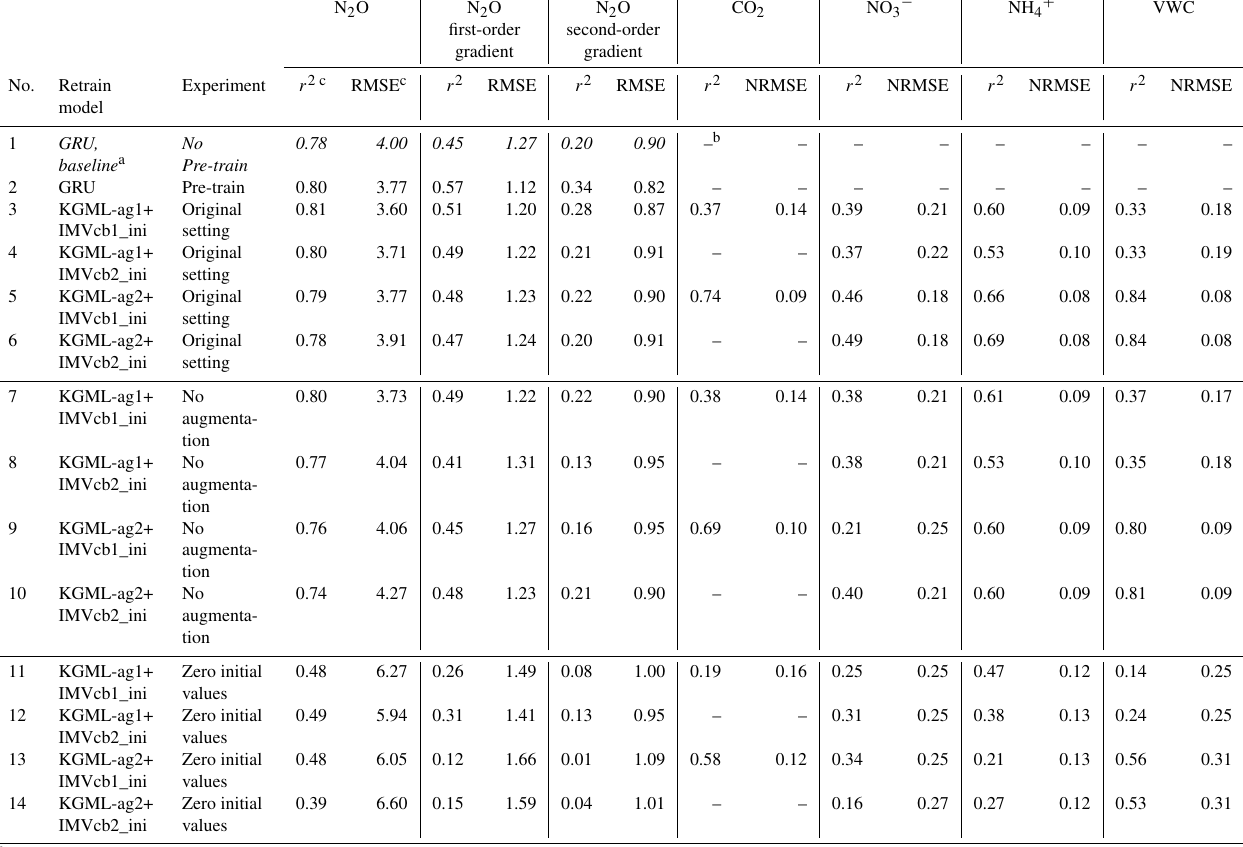
Table 3. Experiments for measuring GRU and KGML-ag model performance and the influence of pre-training process, training data aug- mentation and IMV initial